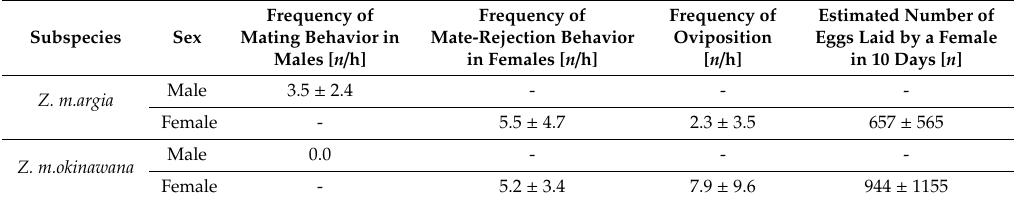
Table 3. Frequency of sex-related behaviors in the two subspecies of Z. maha .